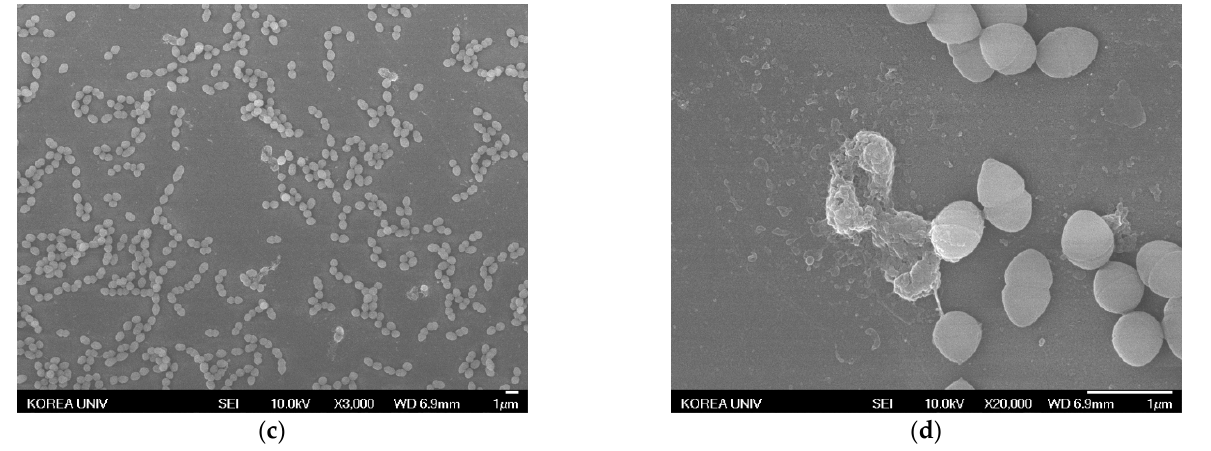
Figure 10. SEM images of MRAB treated with AgNPs. ( a ) Negative control magnified 3000×. ( b ) Negative control magnified 20,000×. ( c ) AgNP-treated MRAB magnified 3000×. ( d ) AgNP-treated MRAB magnified 20,000×.